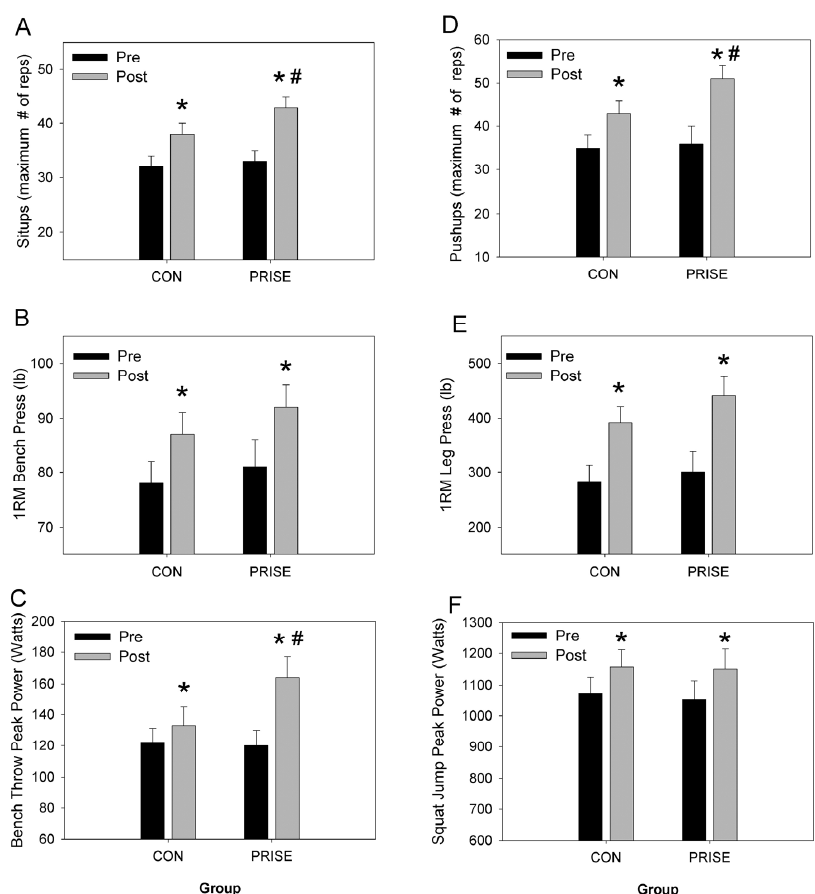
Figure 2. Muscle function parameters at baseline (pre) and after 12 weeks (post) between PRISE and CON. * p < 0.05 pre vs . post training, # p < 0.05 group difference in training response. CON, normal protein; PRISE, protein ‐ pacing. Mean ± SD.